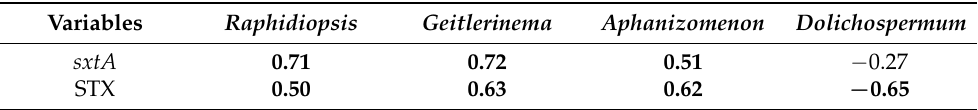
Table 1. Spearman rank correlation coefficients between the biovolume of four potentially saxitoxin producing genera and sxtA gene and saxitoxin concentration (STX) in Itupararanga reservoir (n = 16). Significant correlations ( p < 0.05) are shown in bold.